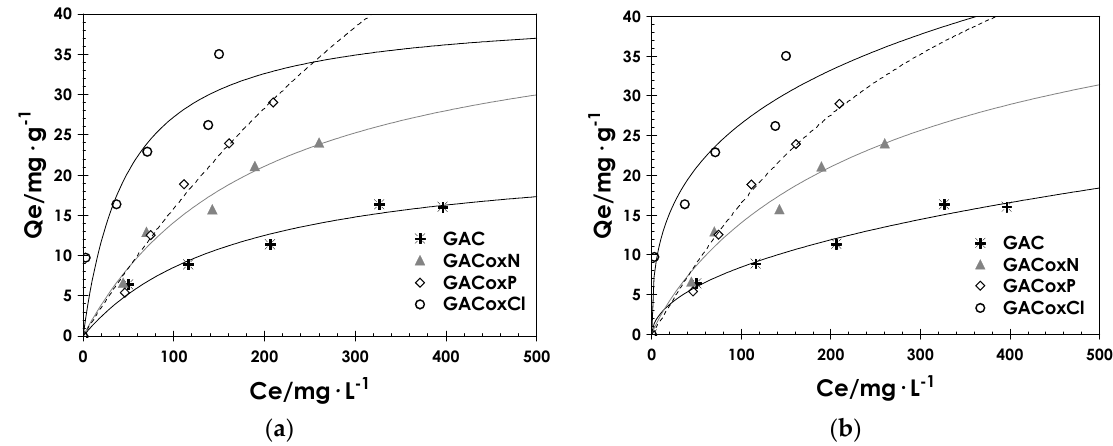
Figure 4. Cadmium adsorption isotherms from aqueous solution on GAC, GACoxN, GACoxP, and GACoxCl, T = 25 °C and pH = 6. The lines correspond to ( a ) Langmuir and ( b ) Sips model.